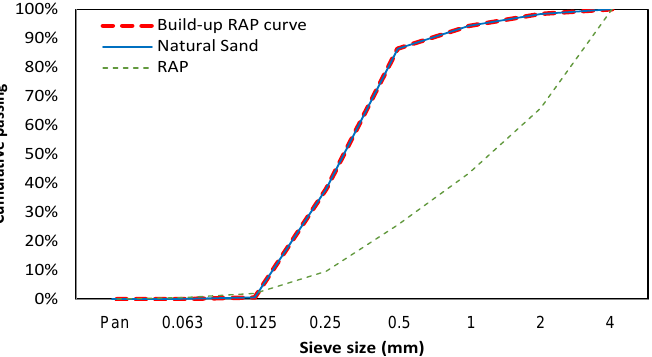
Figure 4. Aggregates particle size distribution.